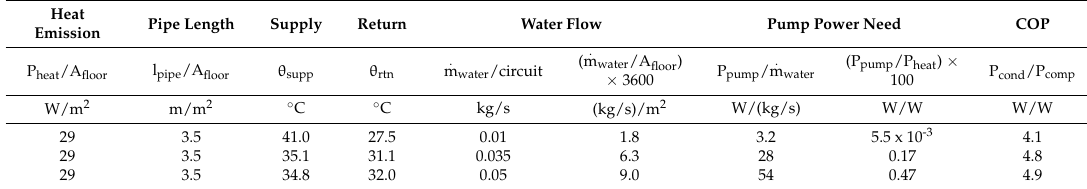
Table 4. The heat emission, pump power need and heat pump efficiency (COP) of a floor heated room of 20 m 2 floor area. Pipe length of heating circuit was set to 70 m and pipe diameter to 13 mm. Energy need for DHW is not considered.